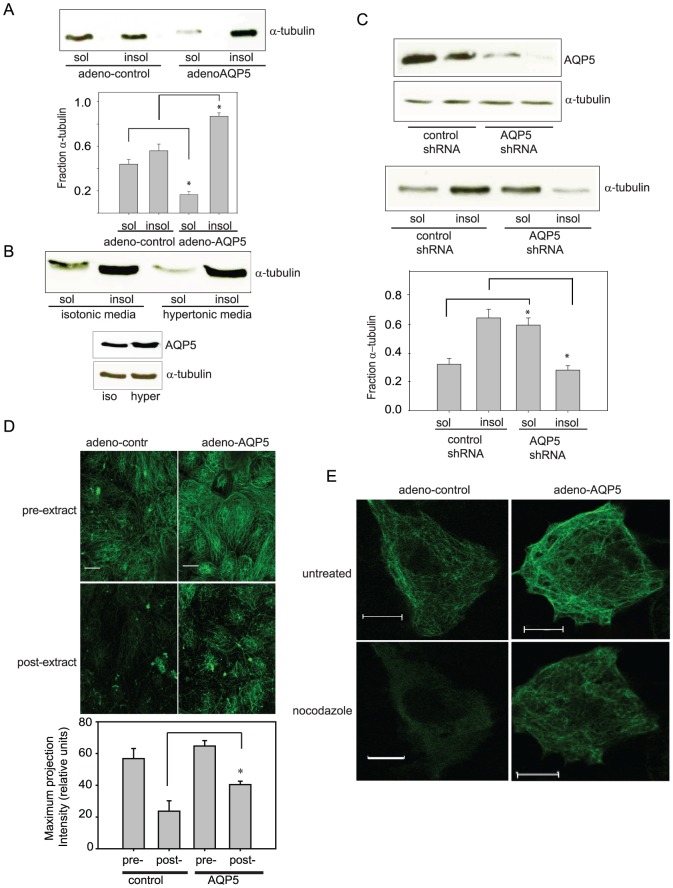
Molecular manipulation of AQP5 altered the MT soluble fraction.A. Transduction of adeno-AQP5 in 16HBE cells led to a significant decrease in soluble tubulin fraction. A representative immunoblot is shown. A bar graph shows the quantification by densitometry (n=4; * p<0.025 with ANOVA one-way). B. In NHBE cells, treatment with hypertonic media led to an increase in the insoluble MT fraction, compared to isotonic control. Hypertonic media caused an increase in total AQP5. (n=2) C. In NHBE cells, knockdown of AQP5 by adenoviral transduction led to an increase in the soluble MT fraction, compared to a scrambled control. Representative immunoblots and bar graphs are shown. (n=4; * p<0.025 with ANOVA one-way). D. Immunofluorescence of tubulin was performed on HBE cells transduced with either control adenovirus or adeno-AQP5 pre- or post- soluble tubulin extraction without a change in intensity settings. In cells with transduced with adeno-AQP5, there is significantly more microtubules visualized post-extraction. Quantitative analysis of these images were performed by obtaining the whole field intensity of the maximum projection intensity of the fields (n=10, *p<0.01) E. Overexpression of AQP5 caused endogenous MTs to be more resistant to nocodazole treatment. 16HBE cells were transduced with either control adenovirus or adeno-AQP5 and MT expression was compared before and after nocodazole treatment (10 µM). No clear change in tubulin polymerization in adeno- control or adeno-AQP5 expressing cells was observed. After 10 min of treatment with nocodazole, a considerable decrease in polymerized tubulin was observed in adeno-control expressing cells. However, the adeno-AQP5 infected cells maintained a substantial level of polymerized tubulin. Scale bar, 10 µm; applies to each frame. (n=10, per condition. Representative figure shown).